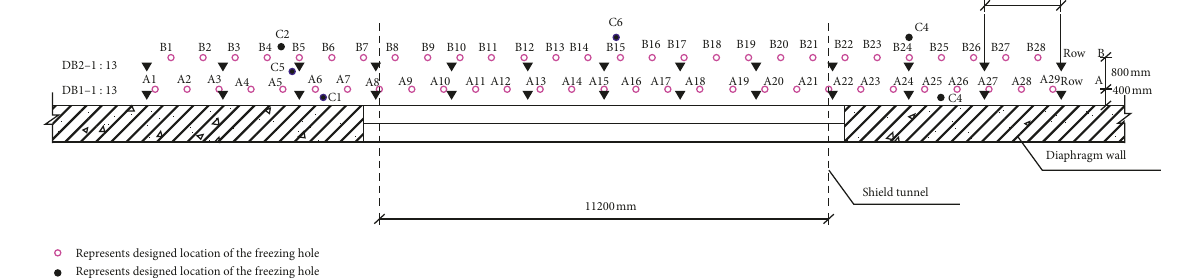
Figure 4: Layout of monitoring locations.